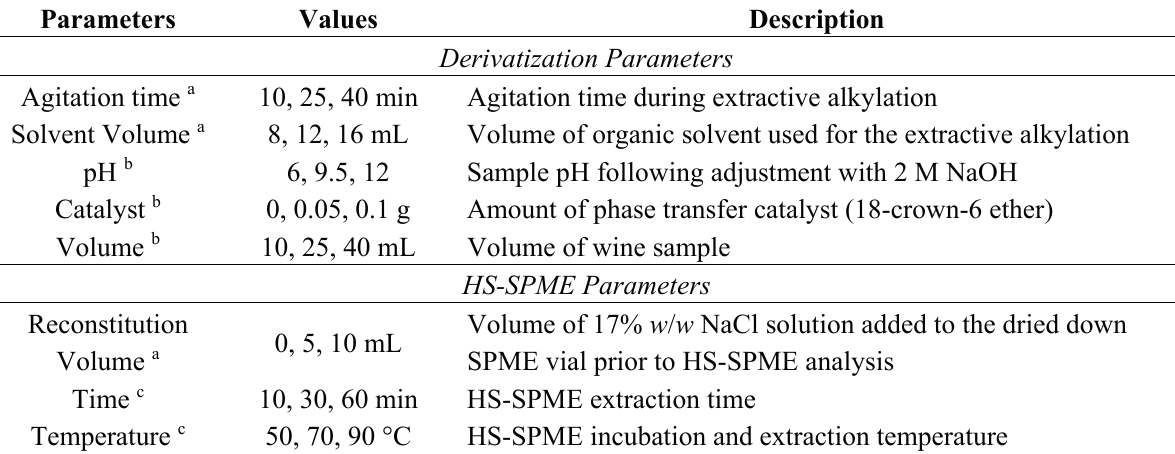
Table 5. Description and range of optimized derivatization and headspace solid phase microextraction (HS-SPME)